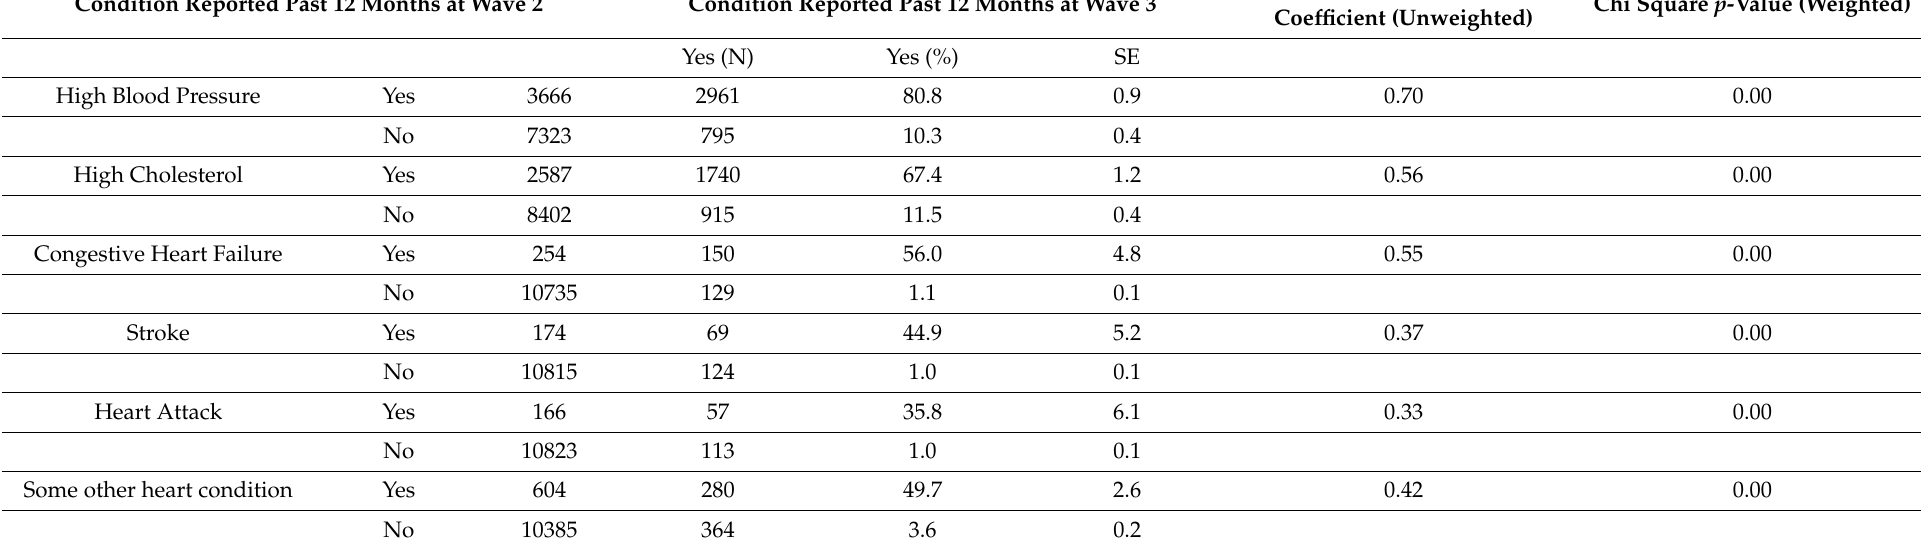
Table 3. Reliability of Cardiovascular Risk Factor and Disease Measures among 11,079 Adults who were Aged 40+ at Wave